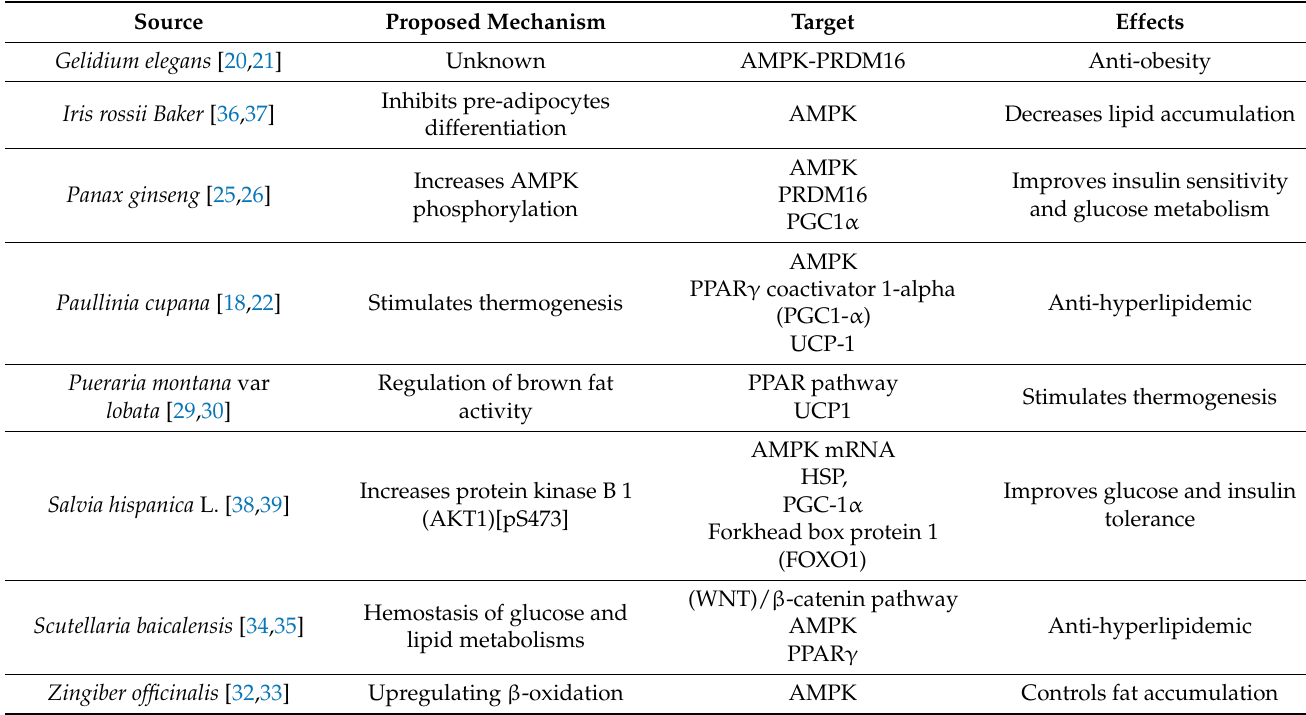
Table 1. Herbs containing nutraceuticals acting as AMPK effectors.